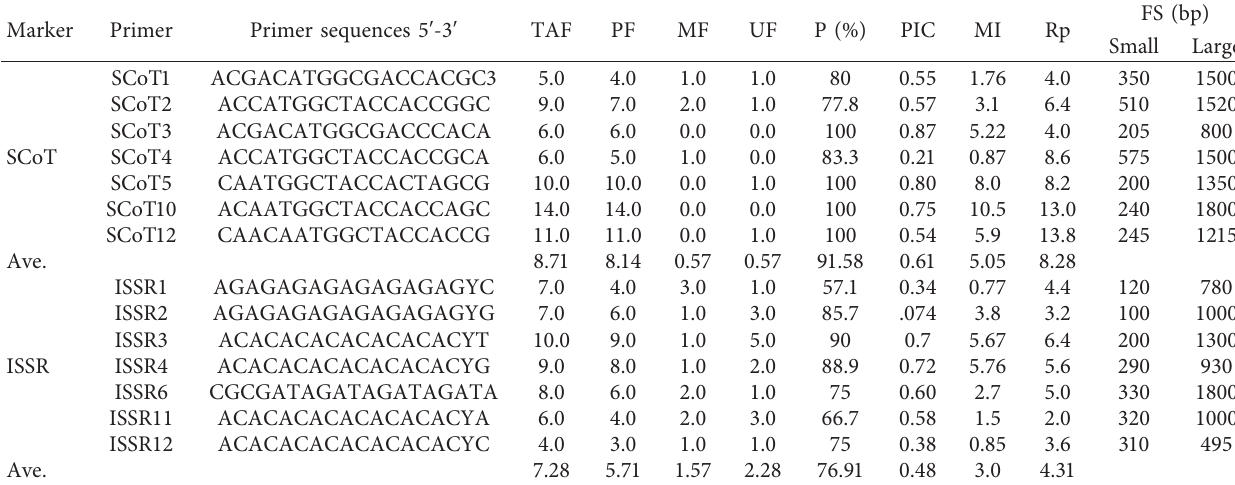
Table 3: Primer sequences, P%, PIC, MI, and Rp in SCoT as well as ISSR primers produced in the ten wheat genotypes. Marker